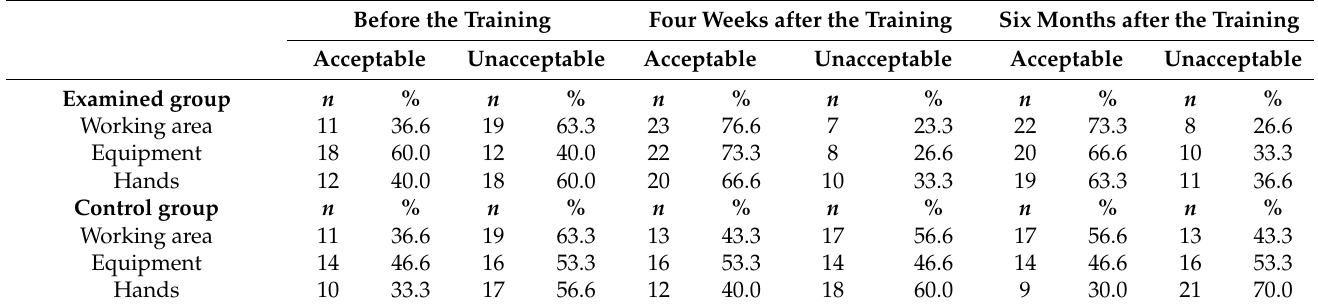
Table 7. TBC of swabs of work surfaces, equipment, and hands of food handlers for pastry